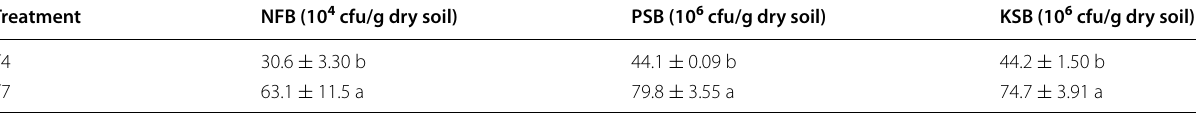
Table 2 Population of beneficial bacteria in the rhizosphere of co-inoculated spinach after 45 days of growth